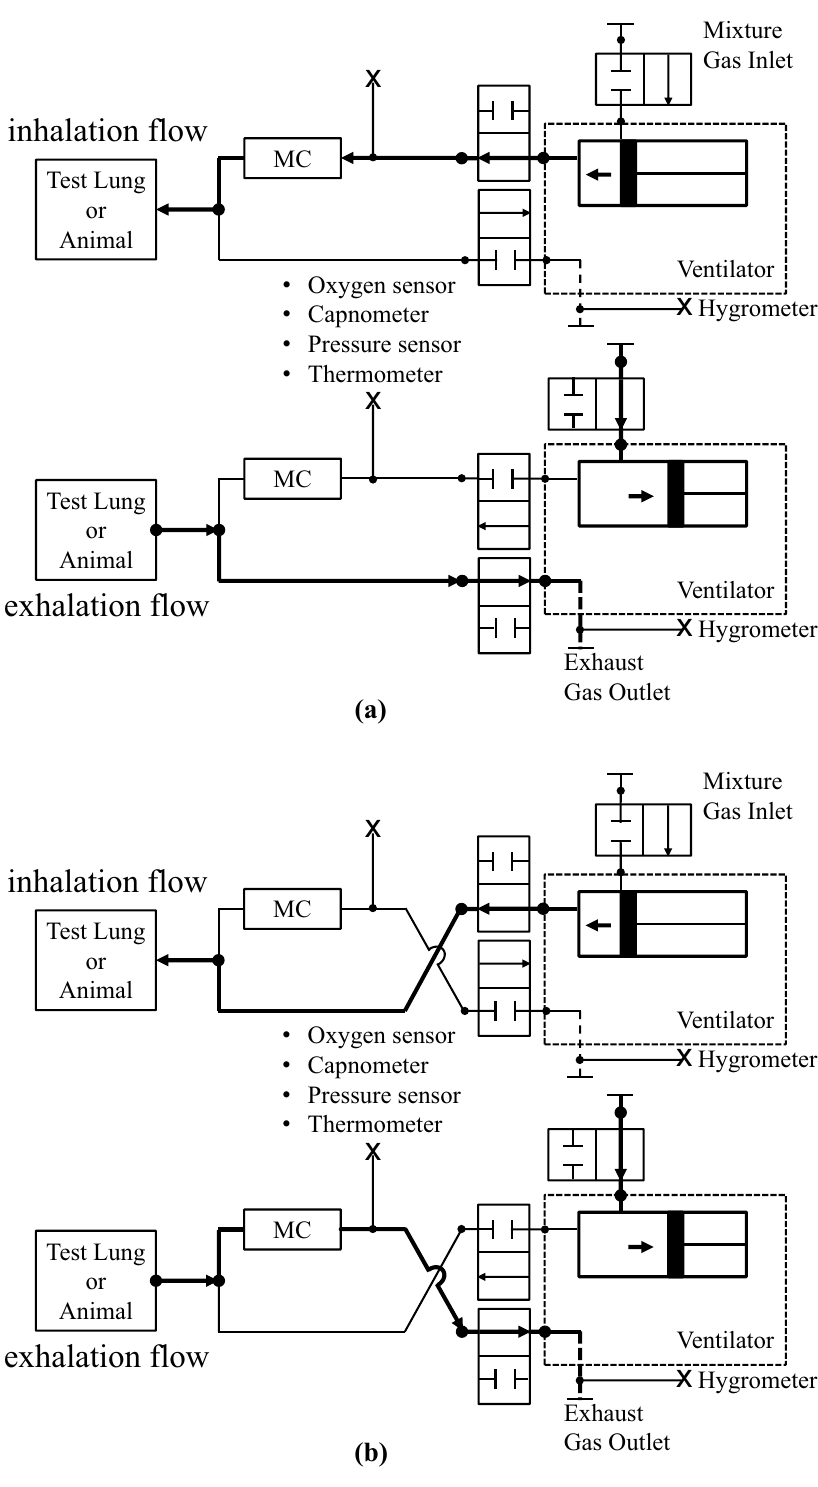
Figure 1. Diagram of the mechanical ventilation circuit. ( a ) Before and after oxygen consumption measurements, FIO2 is measured for at least ten minutes. ( b ) During measurements of oxygen consumption, FEO2 is measured after the ventilator circuit has been switched. O2 extraction is calculated by a subtraction between FIO2 and FEO2. MC indicates mixing